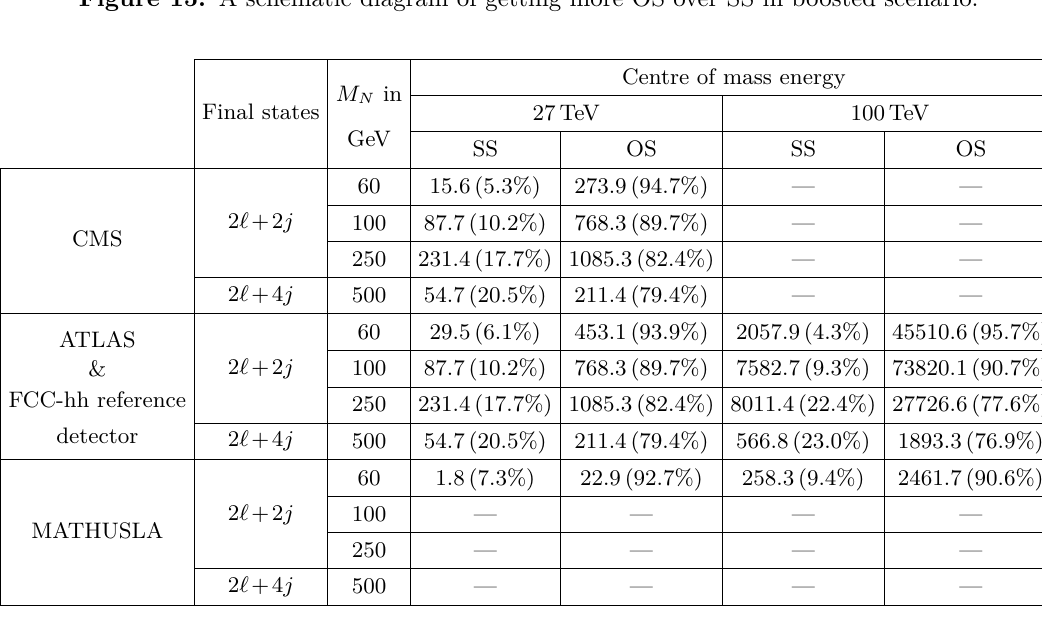
Table 15. Number of events containing SS or OS and their percentage numbers (in bracket) for different RHN masses ( M in GeV) with the centre of mass energies of 27, 100 TeV, at the N integrated luminosities of 10 , 30 ab − 1 , respectively, considering the root sum square values of the Yukawa couplings discussed in subsection